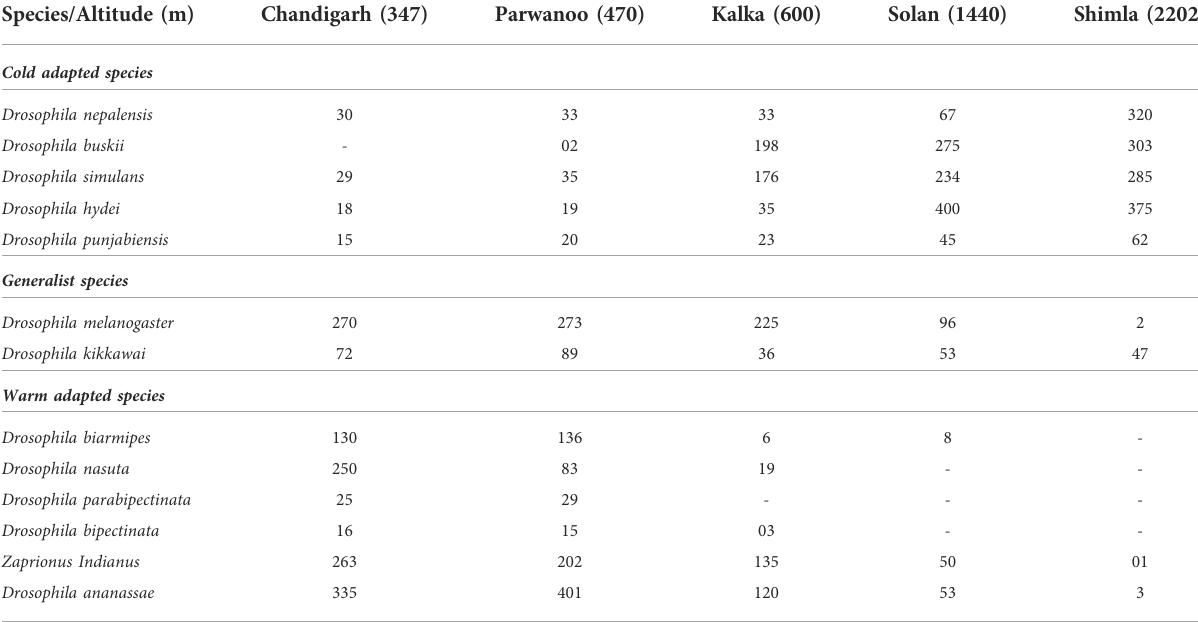
TABLE 2 Number of individuals of different species of Drosophila collected in autumn (October, 2018). Species/Altitude